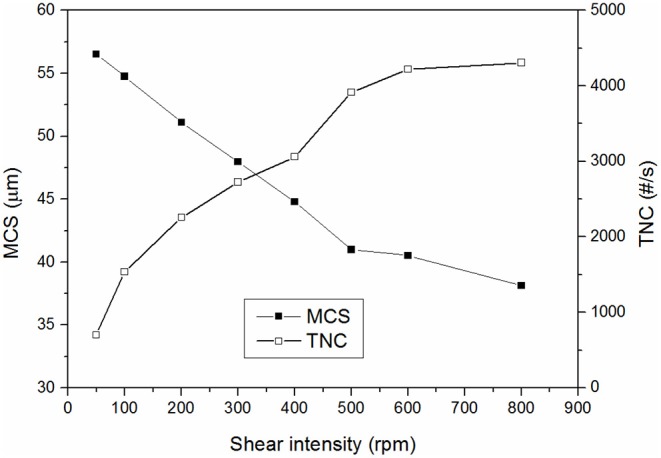
Effect of shear intensity on MCS and TNC of the initial water.